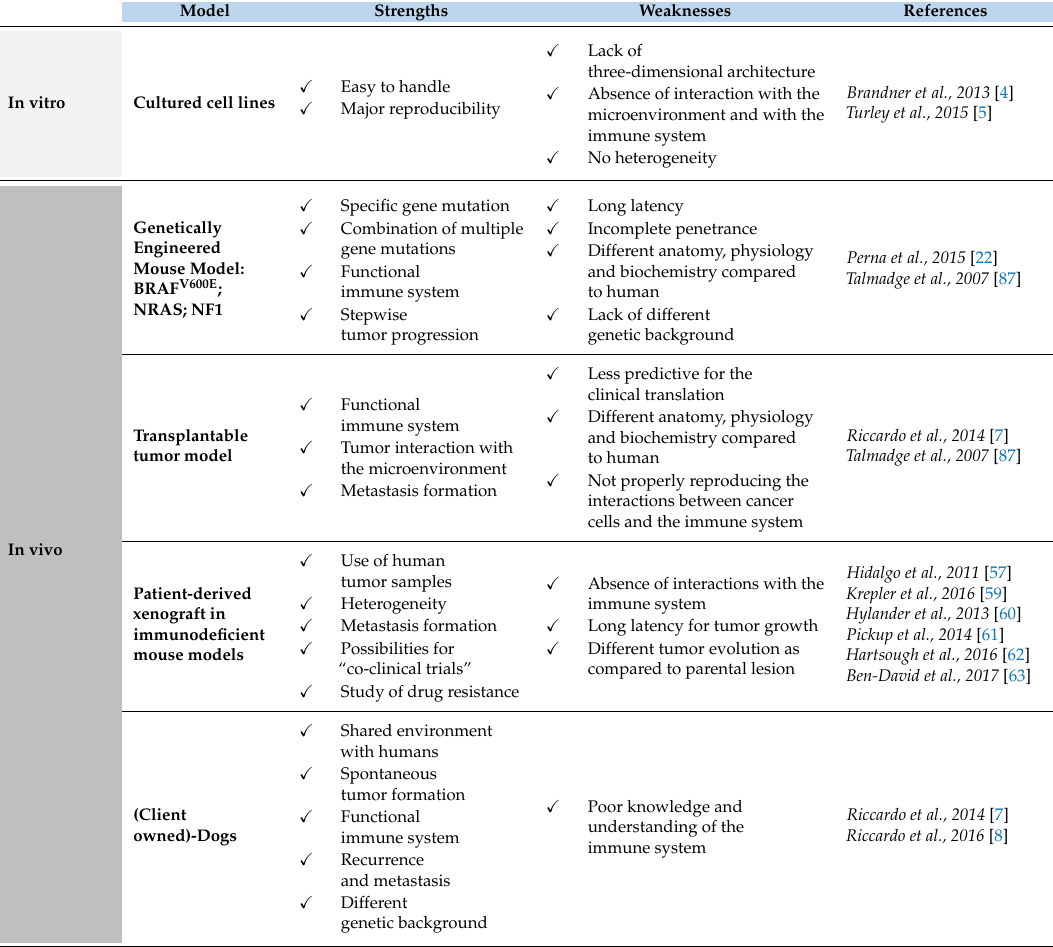
Table 1. Strengths and weaknesses of the translational value of melanoma pre-clinical models. Model Strengths